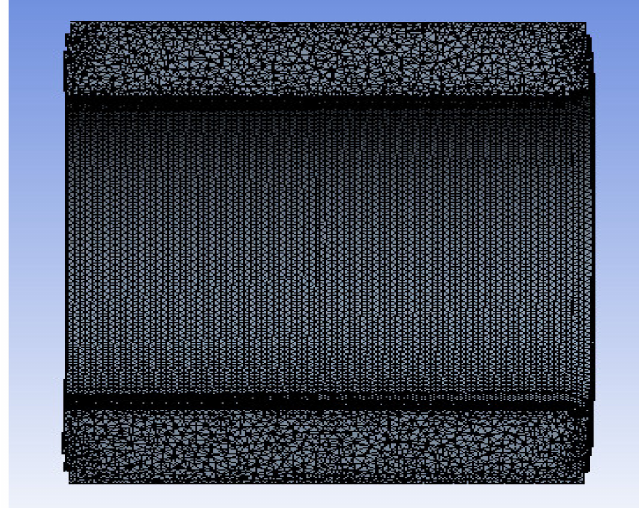
Figure 6. Sectional view of mesh of roller sleeve.